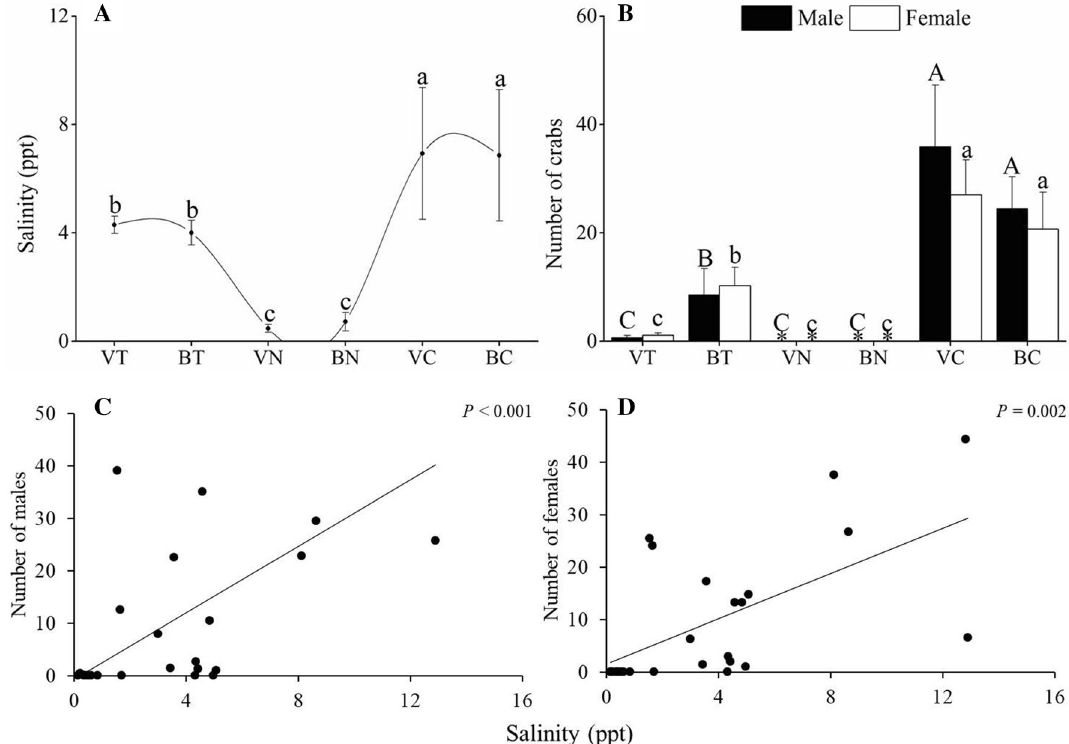
Figure 1. Water salinity (A) and number of C. dehaani crabs (B) in six sampling areas. Values are mean ± SE; N = 4. The correlations between water salinity and numbers of male (C) and female (D) crabs. The abbreviations represent sampling sites: VT and BT, vegetated and bald sites in tidal-affected region; VN and BN, vegetated and bald sites in non–tidal-affected region; VC and BC, vegetated and bald sites BC in natural tidal flat. * indicates that the number of crabs was